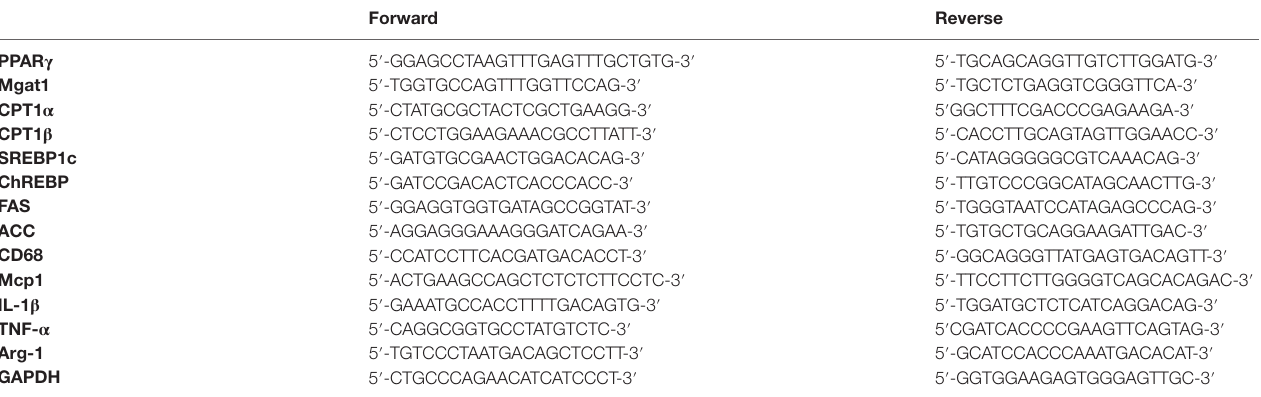
TABLE 1 | Primers used for Qt-PCR analysis of gene expression.